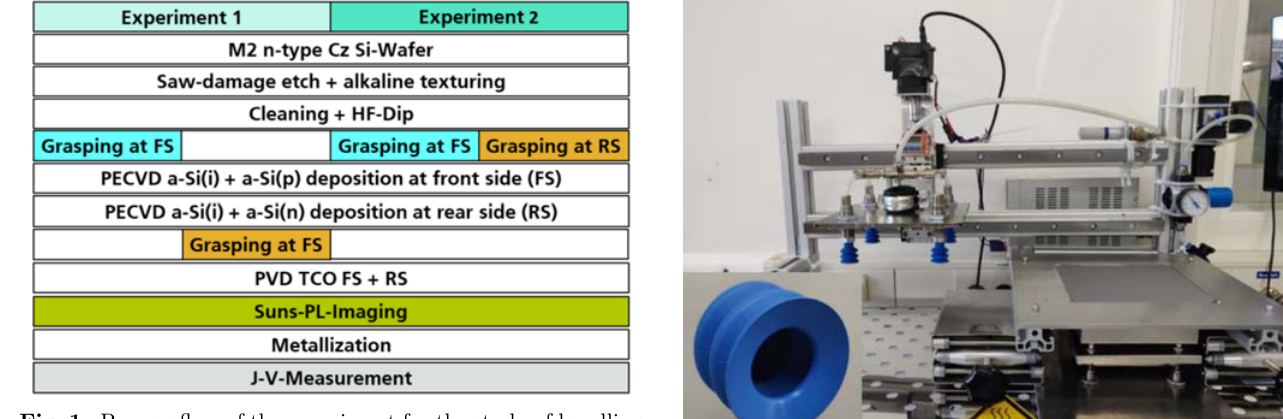
Fig. 1. Process fl ow of the experiment for the study of handling induced defects towards SHJ cell parameters. With wafers either grasped before and after a-Si deposition (Experiment 1) or grasped on the front side (FS) or rear side (RS) before a-Si deposition (Experiment 2).